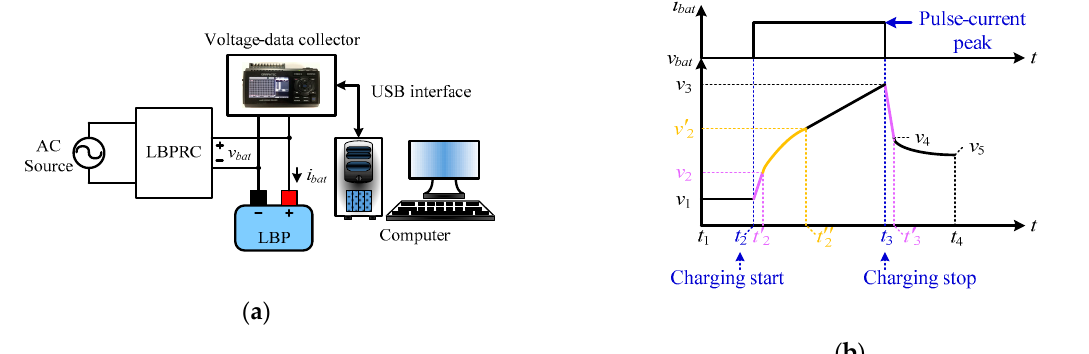
Figure 1. PNGV battery model.